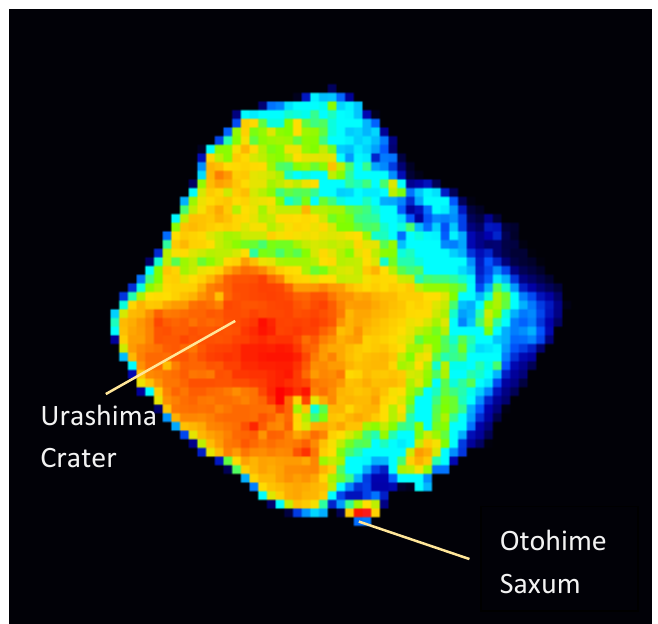
Figure 3. Pseudo-color oblique thermal image of Ryugu on 31 August 2018 taken by TIR from the dusk side (SPE angle of 42 ◦ ). The largest crater Urashima (diameter of 270 m) is seen at the equator, and the largest boulder Otohime is seen at the south pole. The night region shown as the blue color area in the right end of the asteroid is also seen in the thermal image. (Image: hyb2_tir_20180831_130142_l1.fit, © JAXA).